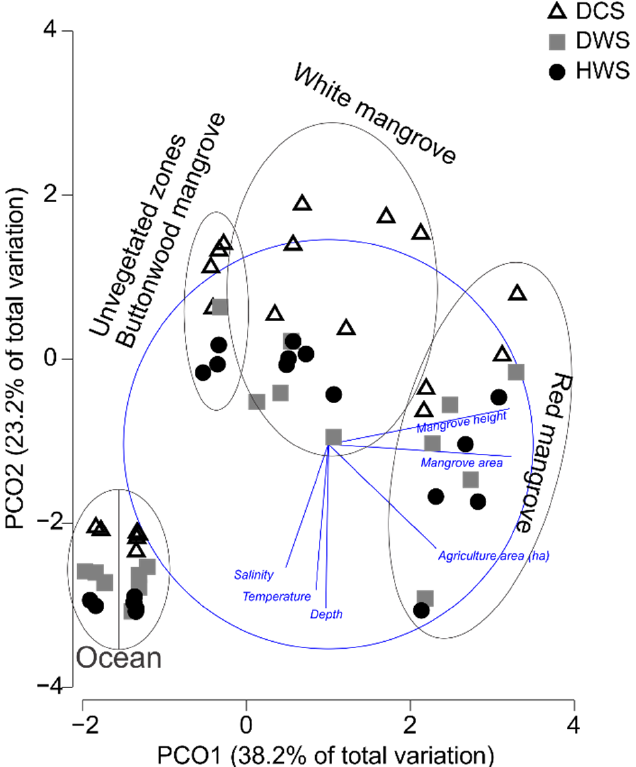
Figure 2. Principal coordinate analysis (PCoA) graph showing relationships among environmental variables with zones and climatic seasons. Climatic seasons are defined as follows: DCS: dry-cold season, DWS: dry-warm season, RWS: rainy-warm season.